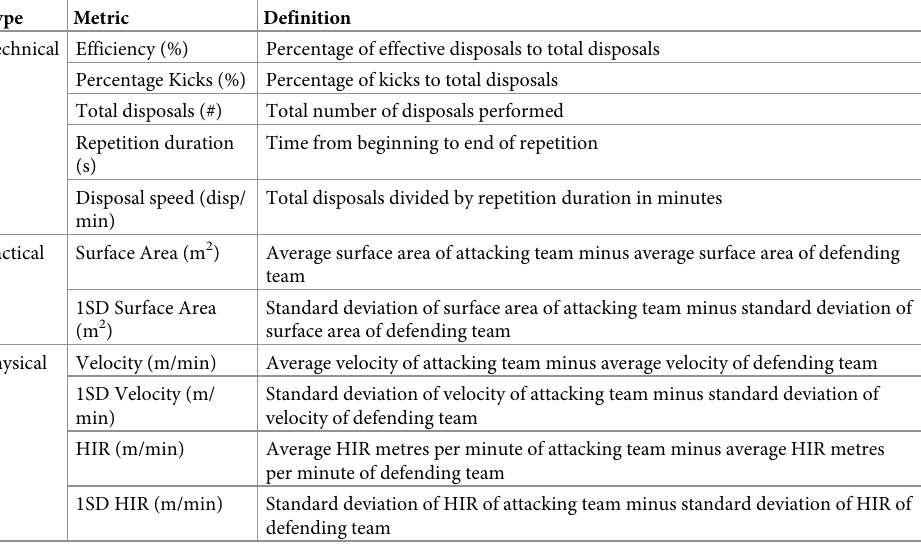
Table 1. Player behaviour metrics and associated definitions. 1SD = one standard